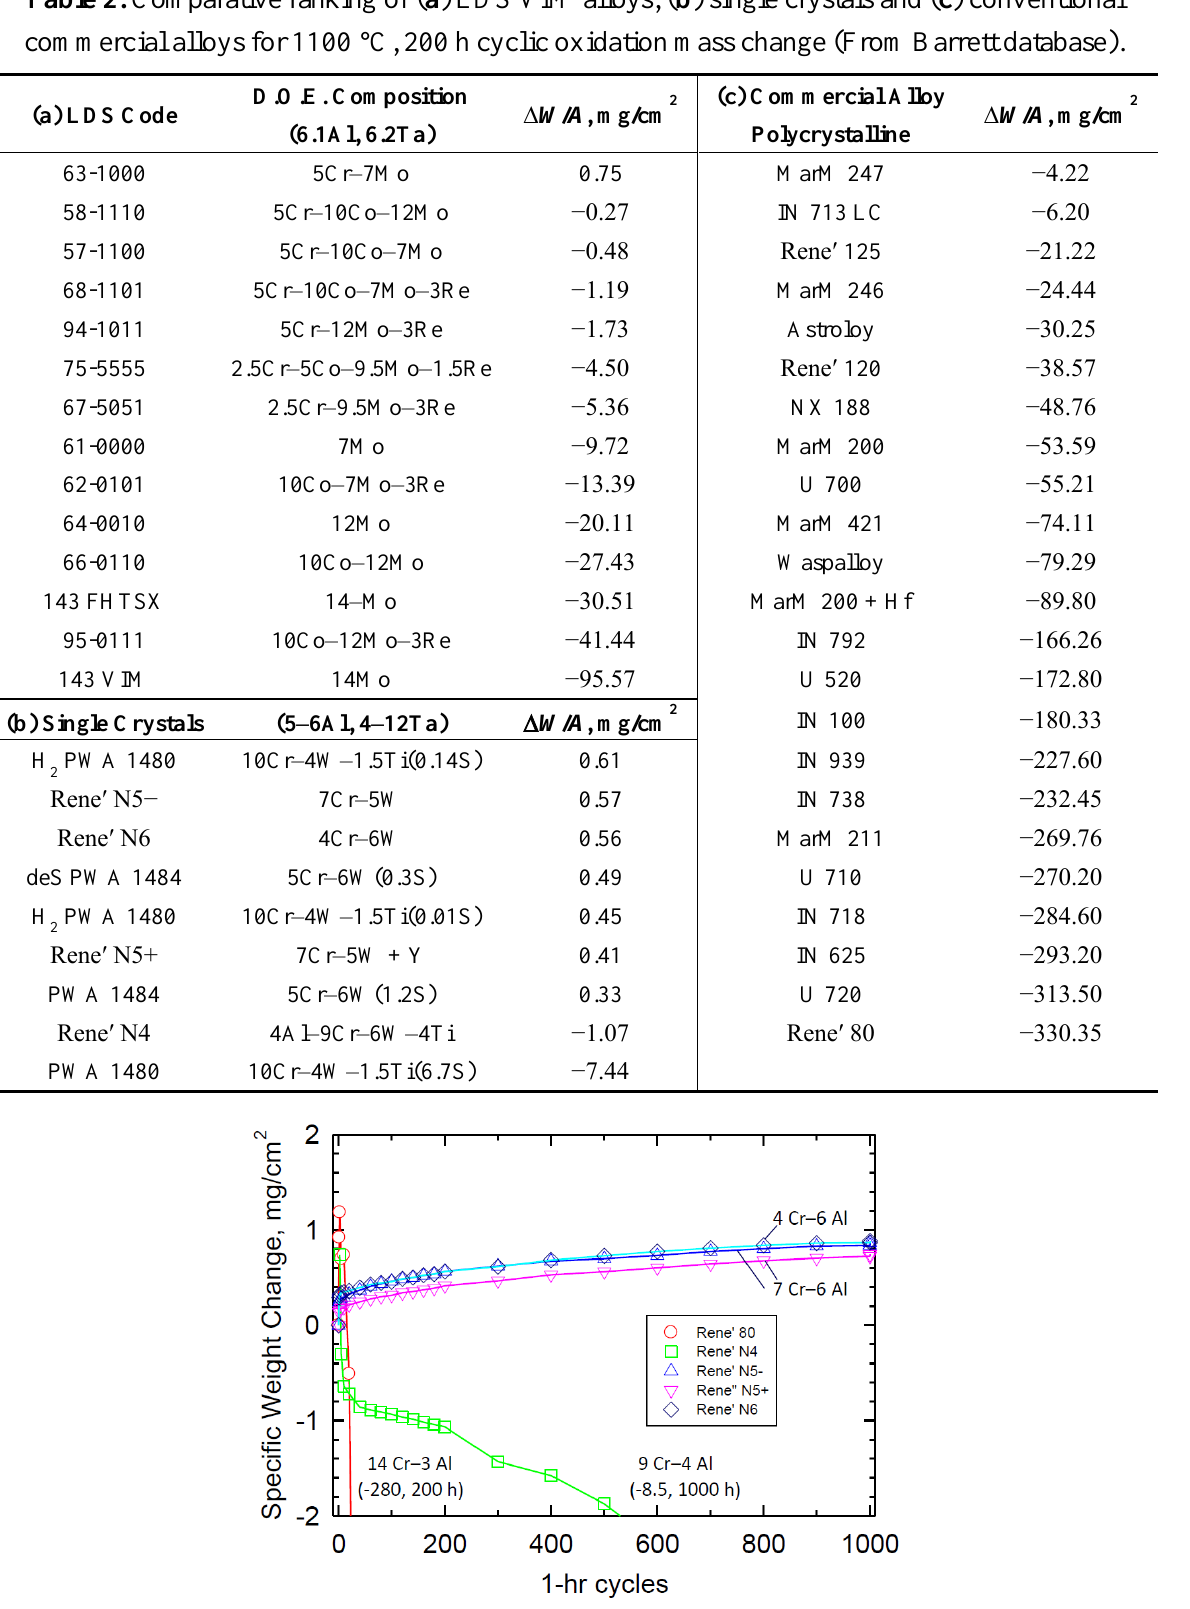
Figure 3. Long term 1100 °C cyclic oxidation weight change for commercial superalloys, showing superb behavior of high Al, zero Ti for Rene′ N5, N6 single crystal superalloys as compared to low < 4Al, high > 4Ti for both Rene′ N4 and